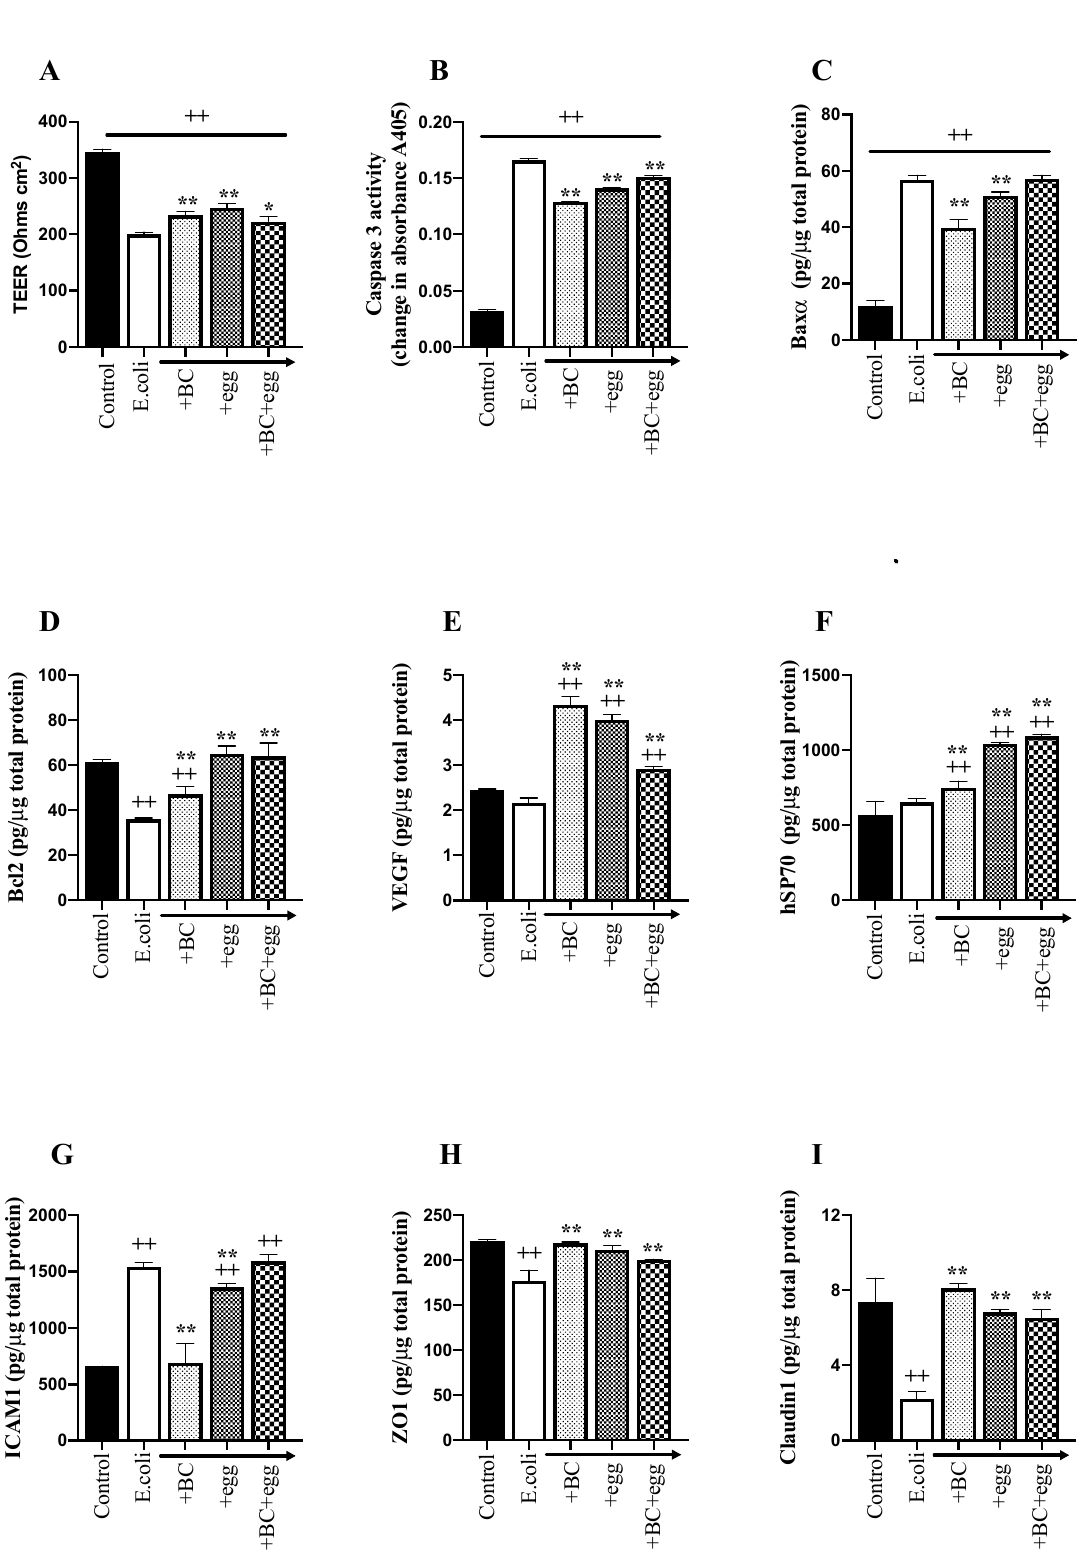
Figure 2. Effect of Escherichia coli ATCC 25922 O6 on Caco-2 monolayer TEER and damaging and repair pathways in the presence of BC, egg, or the combination. E. coli (1 × 10 6 CFU/well) ± BC, egg, or the combination was added to confluent Caco-2 cells; 1 mg/mL of BC alone, 1 mg/mL egg alone or 0.6 mg/mL BC + 0.4 mg/mL egg were used. Changes in TEER ( A ) were determined 24 h later. Following incubation, cleared cell lysates were collected and changes in caspase-3 ( B ), Bax α ( C ), Bcl2 ( D ), VEGF ( E ), Hsp70 ( F ), ICAM-1 ( G ), ZO1 ( H ), and claudin-1 ( I ) were determined. Results expressed as mean ± SEM for 6 wells. ++ signifies p < 0.01 vs. non treated (without bacteria or test product) control, * and ** signify p < 0.05 and 0.01 vs. presence of bacteria alone. The other bacterial strains tested gave similar results (Tables 1–3).and are noted by exception in the